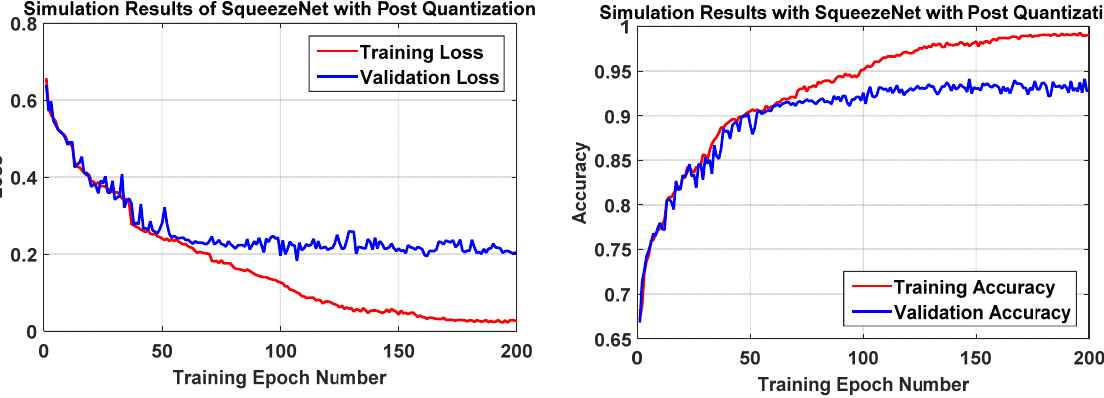
Figure 6. Simulation results of our proposed SqueezeNet model with post-training weight quantization.